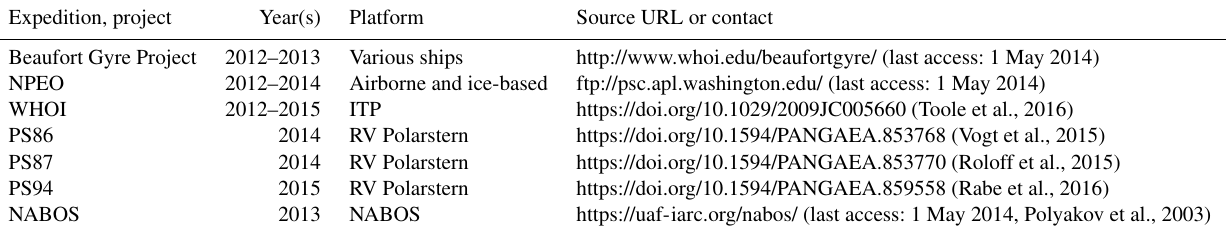
Table 2. Sources of salinity data used in the objective analysis to derive the black curve in Fig. 3. The listed data sources are for the data used in addition to the data described in Rabe et al. (2014a) and published in Rabe et al. (2014b). ITP: ice-tethered profiler; NPEO: North Pole Environmental Observatory; WHOI: Woods Hole Oceanographic Institution; NABOS: Nansen and Amundsen Basin Observational System. Expedition,